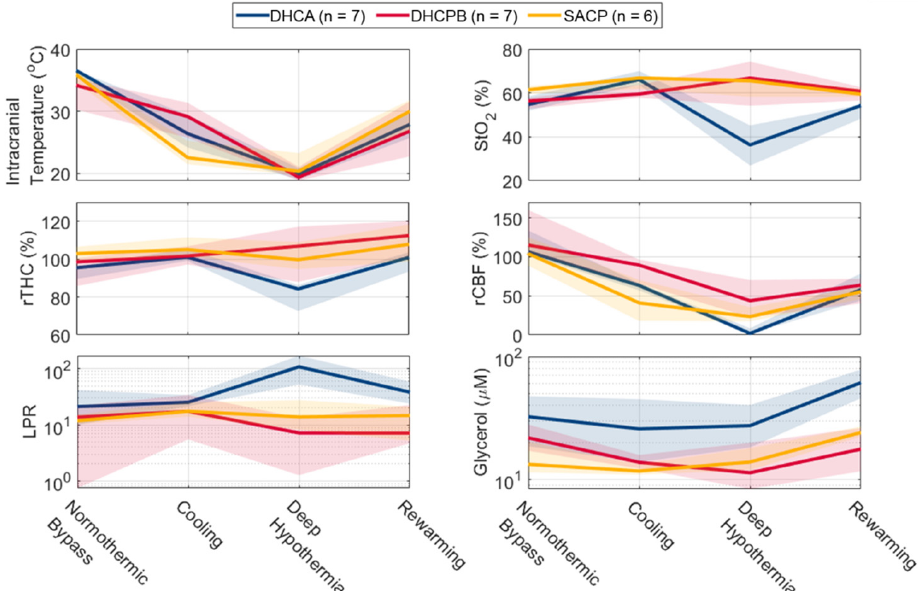
Figure 2. Summary of Cerebral Physiologic Parameters at Microdialysis Sampling Timepoints. The median ( bold line ) and interquartile range ( shaded ) within each group are summarized for measured physiologic parameters at each microdialysis sampling timepoint. Abbreviations : DHCA, deep hypothermic circulatory arrest; DHCPB, deep hypothermic cardiopulmonary bypass; SACP, selective antegrade cerebral perfusion; rTHC, relative total hemoglobin concentration; LPR, lactate–pyruvate ratio; StO 2 , tissue oxygen saturation; rCBF, relative cerebral blood flow.